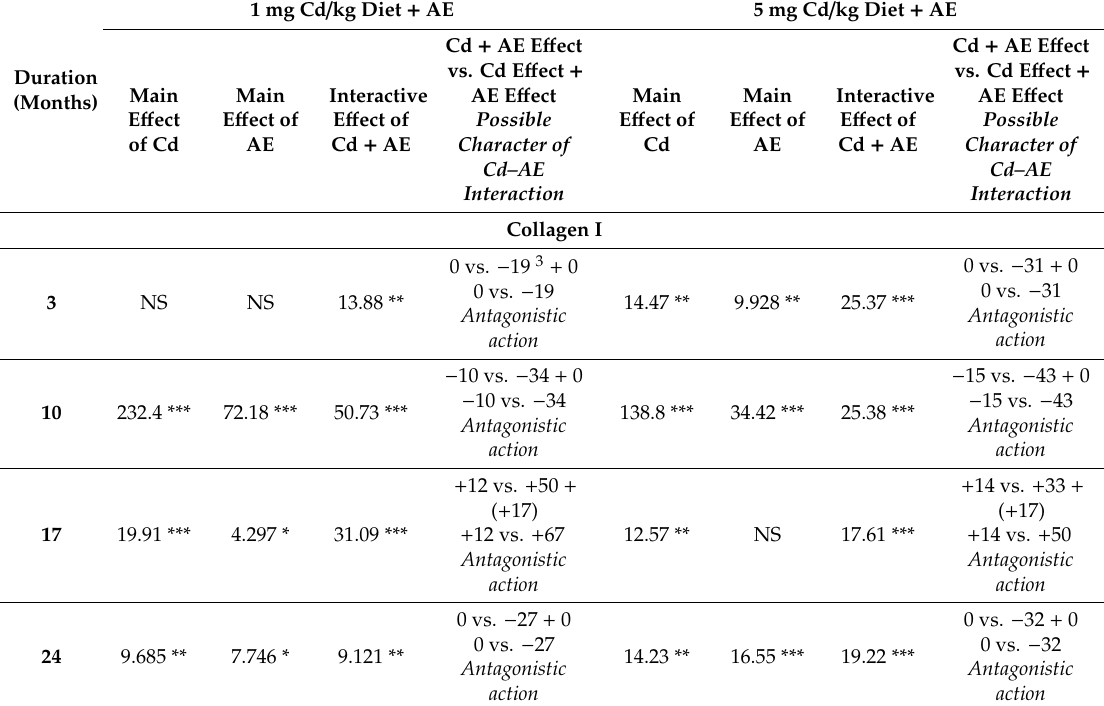
Table 2. Evaluation of the main and interactive e ff ects of cadmium (Cd) and Aronia melanocarpa L. berry extract (AE) on the expression of collagen type I and collagen type III at the protein level in the livers of rats 1,2